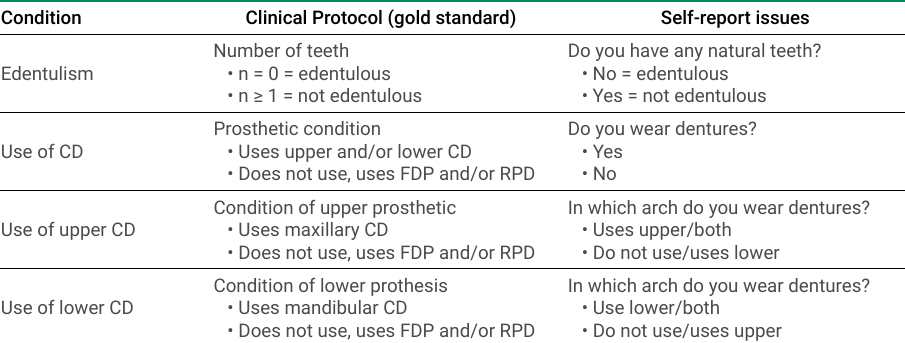
Table 1. Equivalences between clinical examination and self-report issues to assess oral health condition.